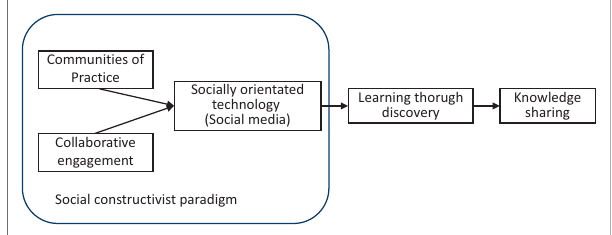
FIGURE 4: Conceptual framework for knowledge transfer in SA public